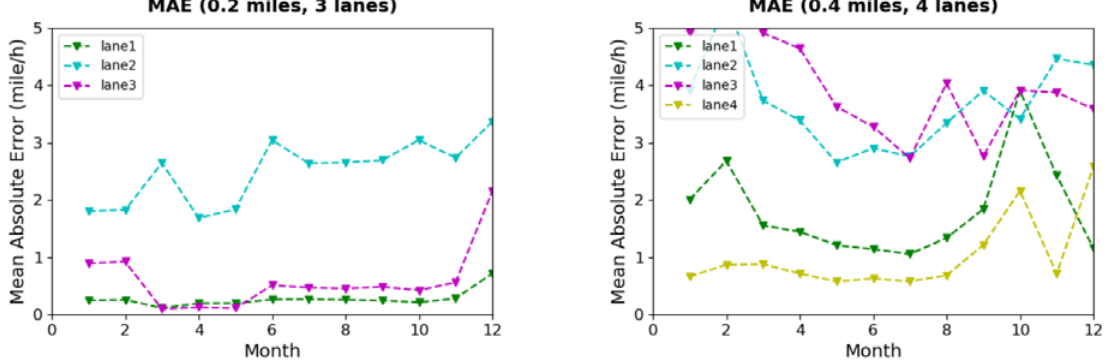
Figure 8. Segments where errors of middle lanes bigger than side lanes.